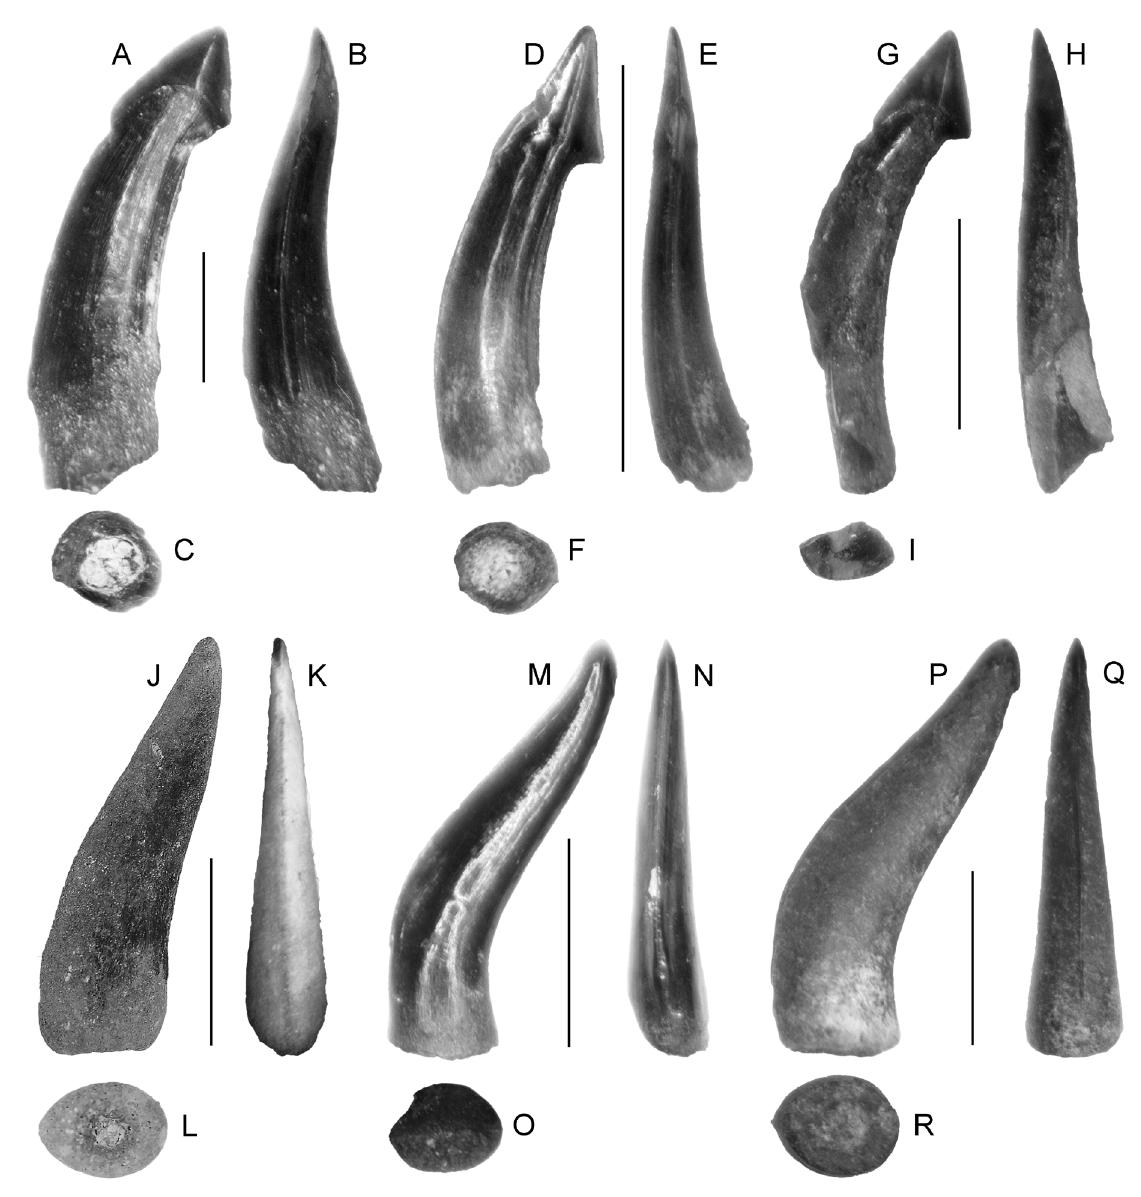
Fig. 63. Trichiurides sagittidens Winkler, 1874 and Trichiurus oshosunensis White, 1926, teeth. A–I . Trichiurides sagittidens . A–C . MSC 12800, , basal Gosport Sand. A . Lingual view. B . Anterior view. C . Basal view. D–F . MSC 2405.1, Gosport Sand. D . Lingual view. E . Anterior view. F . Basal view. G–I . MSC 37486, basal Gosport Sand. G . Lingual view. H . Anterior view. I . Basal view. — J–R . Trichiurus oshosunensis . J–L . MSC 38489.1, basal Lisbon Formation. J . Profile view. K . Anterior